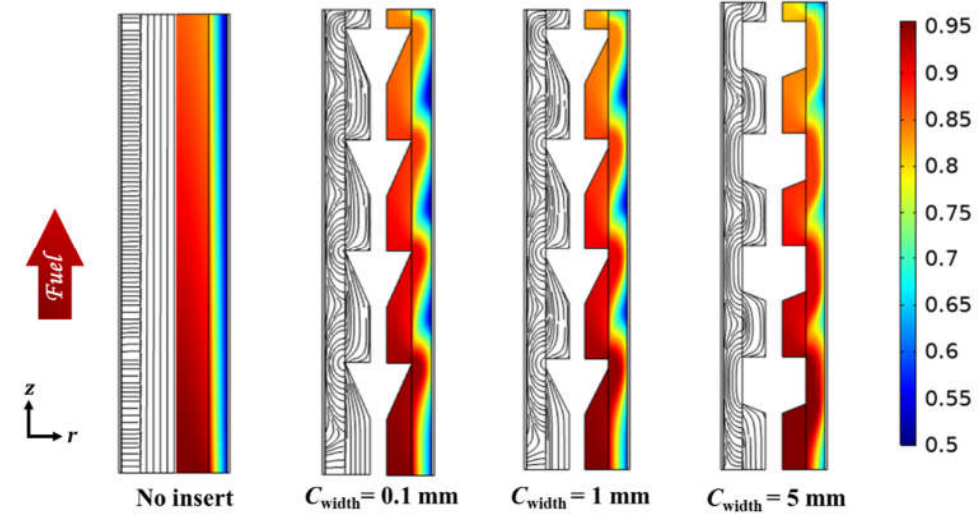
Figure 7. The streamlines and CO mole fractions of the micro-tubular SOFCs, without an insert and with cone-inserts of different widths (the thickness of the cone base).